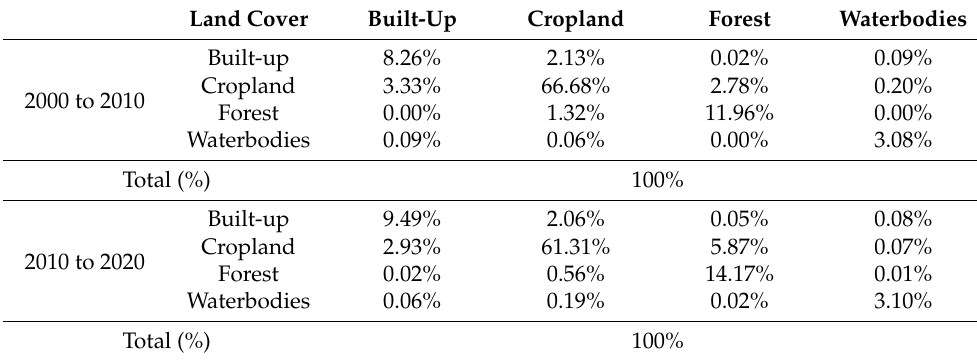
Table 4. Area change ratios of land-cover types in 2000–2010 and 2010–2020. Land Cover Built-Up Cropland Forest